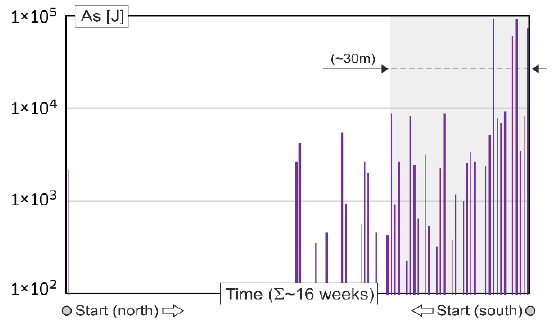
Figure 12. Histogram of seismic energy release — bottom heading Y#4.